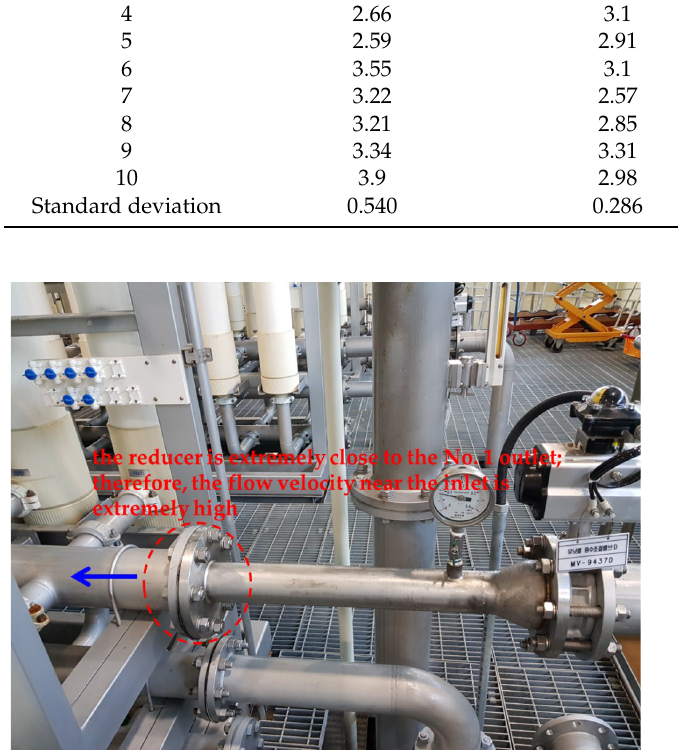
Figure 9. Location of reducer (the reducer is extremely close to the No. 1 outlet; therefore, the flow velocity near the inlet is extremely